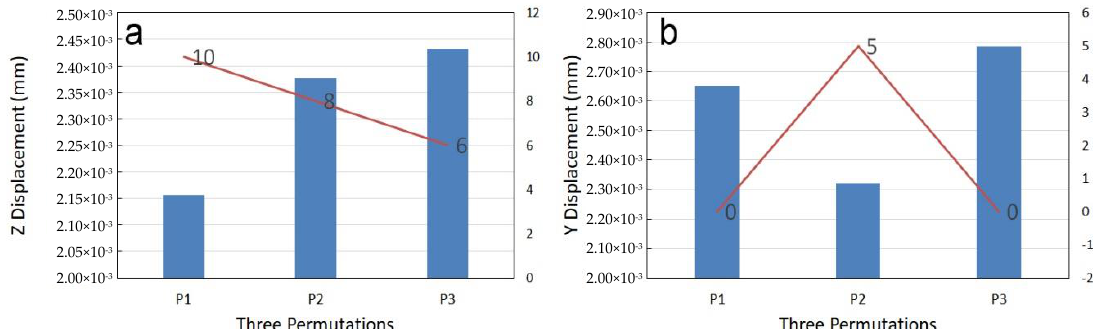
Figure 6. Displacements along the Z and Y axes under compression with a loading level of 0.5 MPa. ( a ) The displacement of stressed surface along the Z-axis; ( b ) The displacement of the stressed surface along the Y-axis. The sums of row/column/layer sum maxima of feature matrices are plotted by the red line.